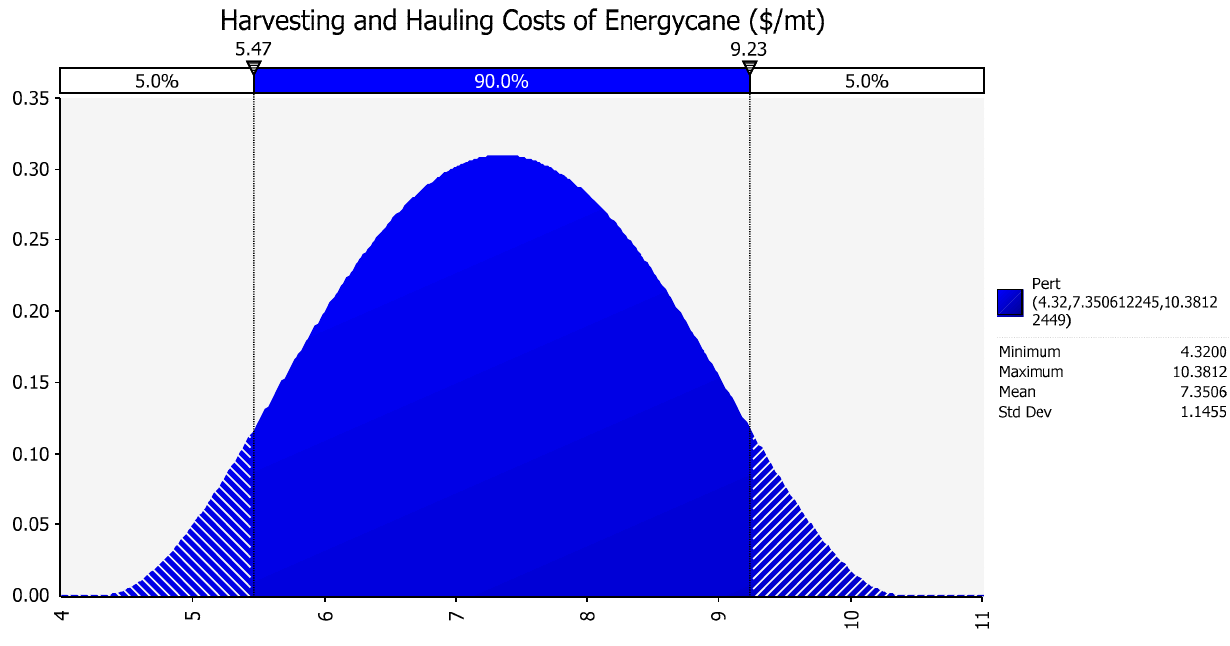
Figure 4. Distribution of transportation and hauling costs of energycane.